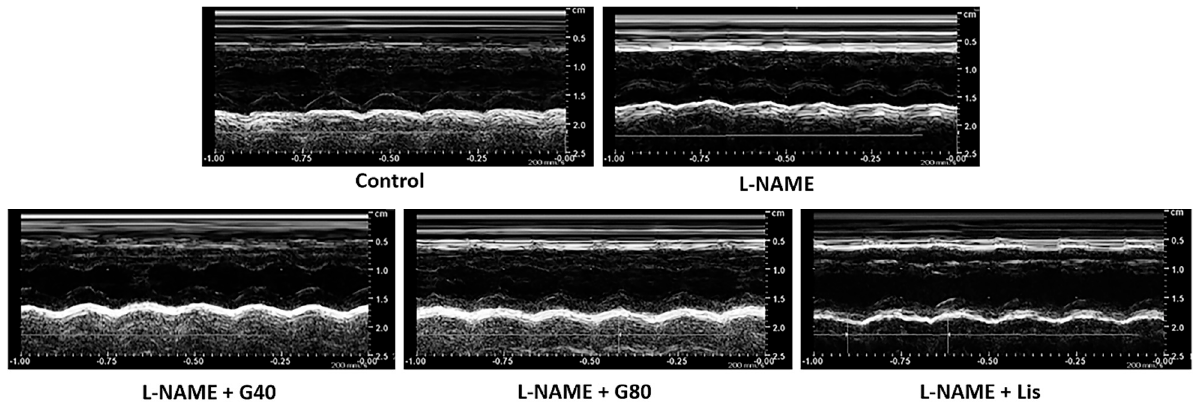
Figure 2. Representative M-mode echocardiographic tracings in each group, resolution 700 dpi. Control, normotensive rats; L-NAME, N ω -nitro-L-arginine methyl ester hydrochloride; L-NAME + G40, L-NAME hypertensive rats treated with genistein 40 mg/kg; L-NAME + G80, L-NAME hypertensive rats treated with genistein 80 mg/kg; and L-NAME + Lis, L-NAME hypertensive rats treated with lisinopril 5 mg/kg.